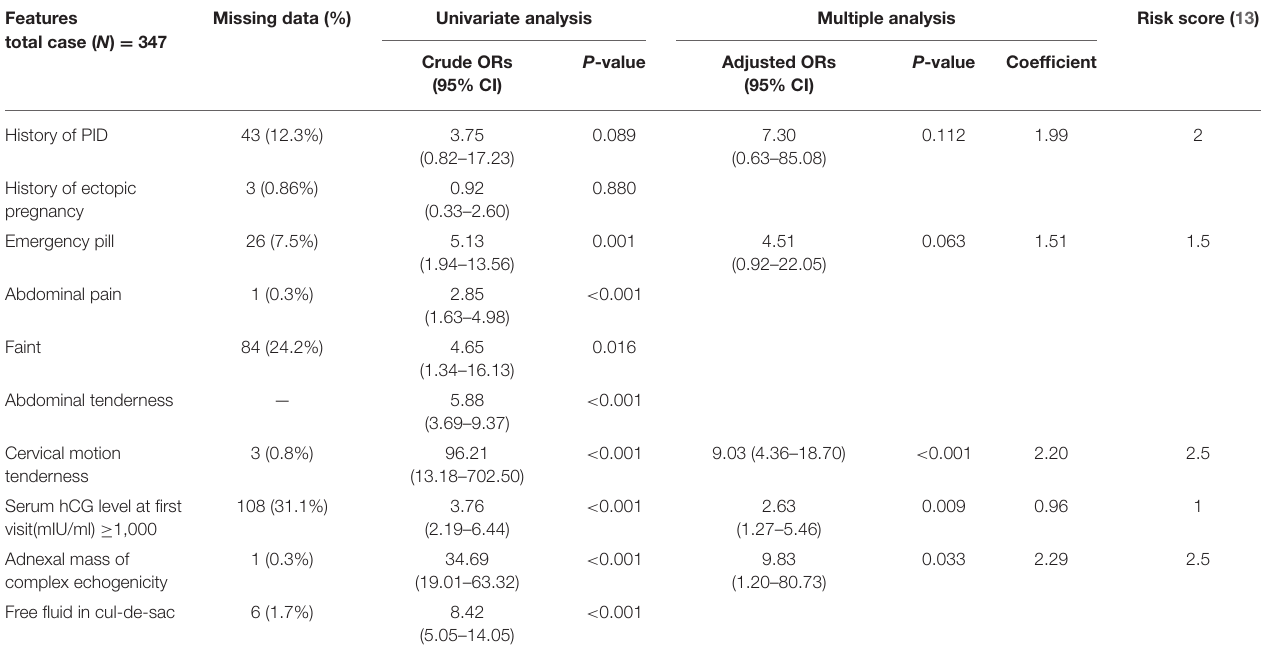
TABLE 2 | Univariate and multivariate logistic regression analyses of the factors significantly associated with ectopic pregnancy and scoring system. Features total case ( N ) =